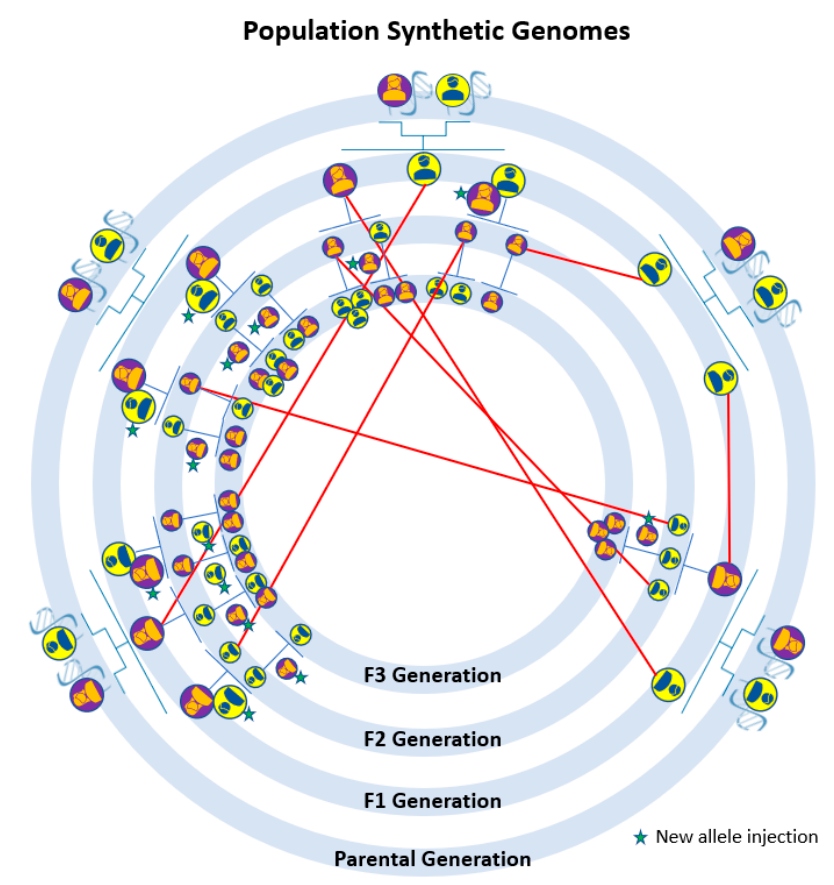
Figure A6. Generation of an entire population of synthetic genomes.